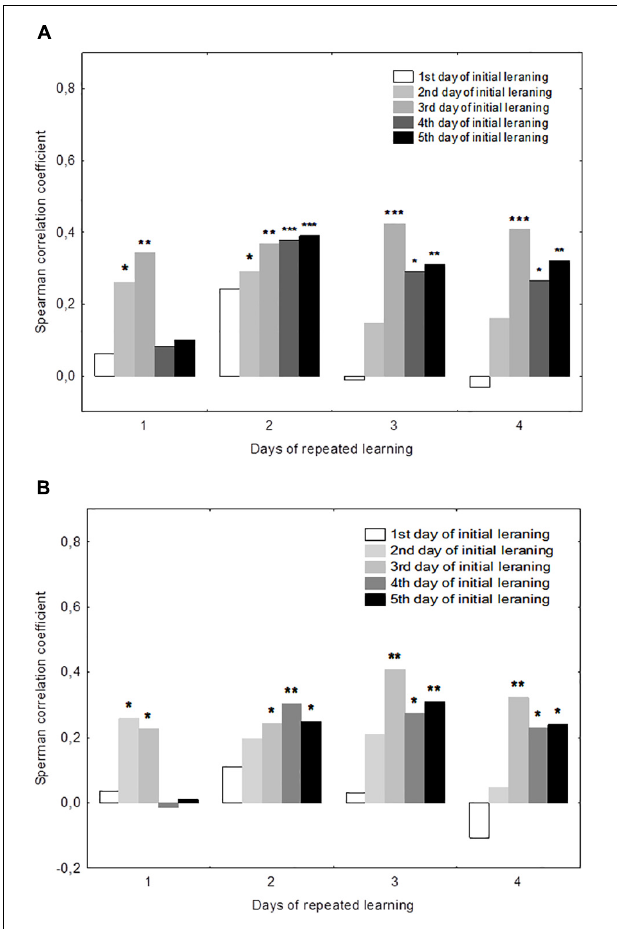
FIGURE 3 | Correlations between performance measures in the initial and repeated learning. (A) Correlations between the daily mean escape latencies during repeated learning (days 19–22) and the daily mean escape latencies during initial learning (days 1–5). (B) Correlations between the escape latency for the first trial for each day of repeated learning (days 19–22) and the daily mean escape latencies during initial learning (days 1–5). * p < 0.05, ** p < 0.01, and *** p < 0.001 indicate the significance of Spearmen’s